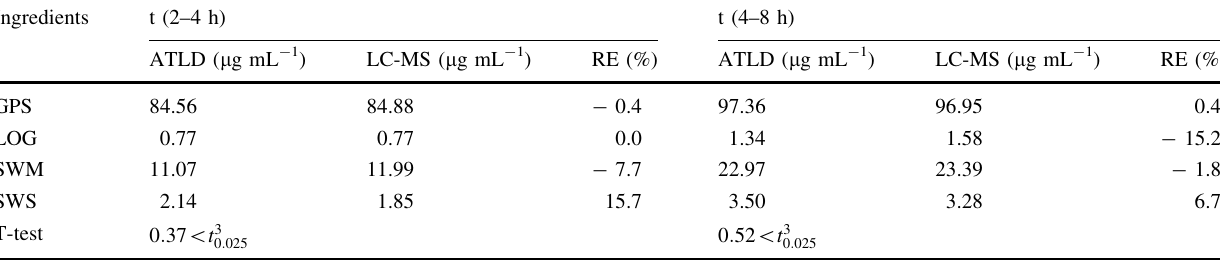
Table 7 The comparison of simultaneous determination of four bioactive ingredients in urine samples by the algorithm of ATLD and LC-MS